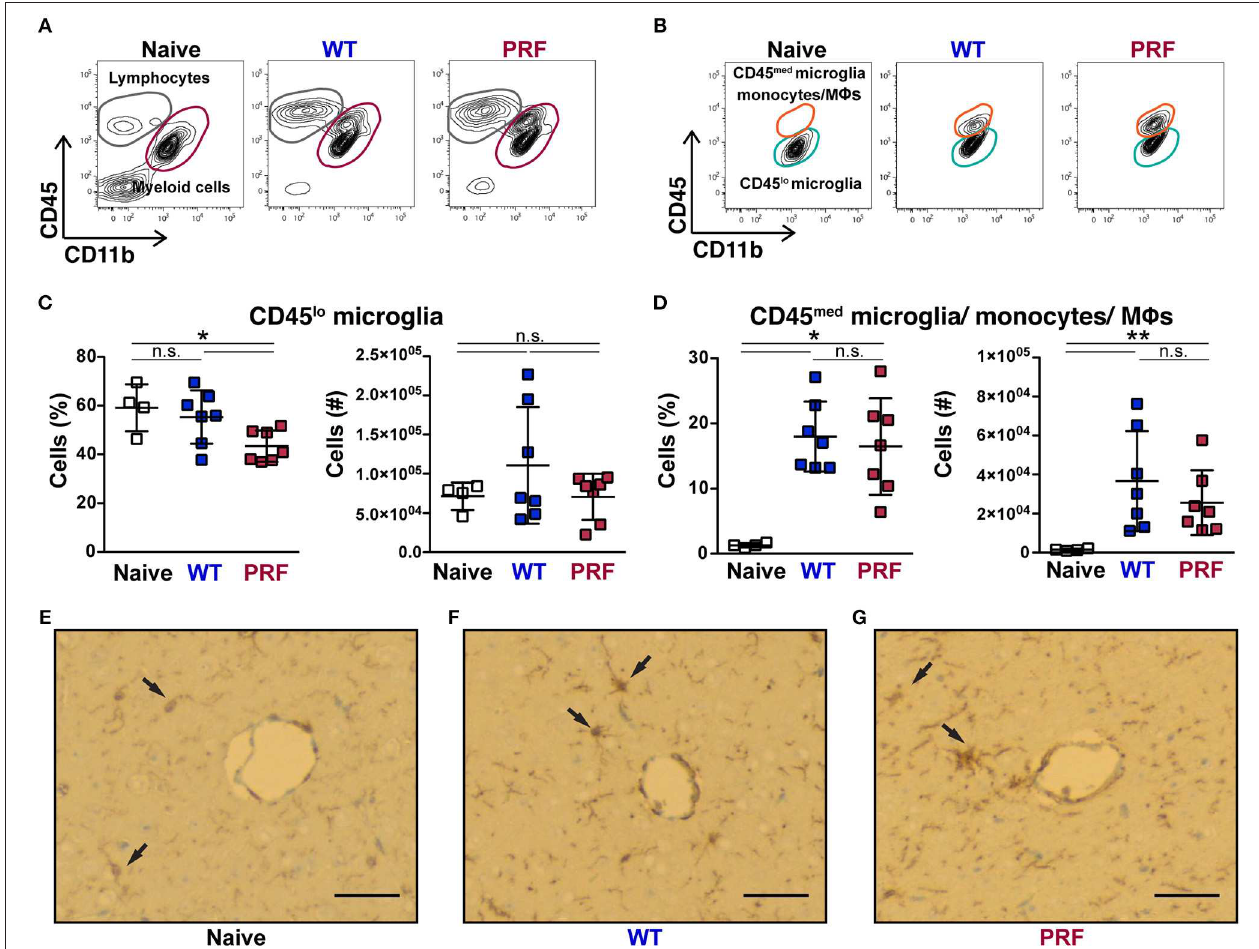
FIGURE 5 | Quantification of myeloid cells after infection. (A) Representative contour plots from day 8 after infection showing CD45 vs. CD11b expression on live cells obtained from naïve mice (left), and mice infected with WT (center) and PRF (right) sporozoites. Indicated are gated populations of lymphocytes, CD45 hi CD11b − cells (gray circles) and myeloid cells, CD45 med / lo CD11b + cells (red circles). (B) CD45 vs. CD11b expression on the Ly6G − myeloid population. CD45 lo CD11b + cells (orange circles) represent microglia and CD45 med CD11b + cells (green circles) activated microglia, monocytes and macrophages, respectively. (C) Quantification of CD45 lo microglia. Shown are percentage (left) and absolute numbers (right) of CD45 lo Ly6G − CD11b + microglia. (D) Quantification of CD45 med Ly6G − CD11b + cells, which correspond to CD45 med microglia, monocytes and macrophages. Shown are percentage (left) and absolute numbers (right) of CD45 med microglia/monocytes/macrophages in the brain. The scatter dot plots in (C,D) represent mean values ( ± SD ) from samples ( n = 4–7) isolated 8 days after infection from two independent experiments. n.s, non-significant; * P < 0.05; ** P < 0.01 (Mann-Whitney test). (E–G) Representative images from the IBA-1 + microglial cells of brain histological cross-sections. Cerebral vessels are indicated by arrows. The IBA-1 staining reaction was visualized with diaminobenzidine (DAB), highlighting some microglial cells with thin processes in naïve mice, while they are more prominent in WT sporozoite-infected mice and they also tend to cluster around vessels. This feature is also pronounced in PRF sporozoite-infected mice, dark brown. Scale bar, 50 µ